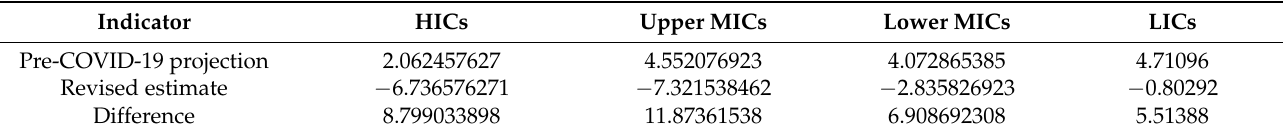
Table 4. Projected and estimated GDP growth in 2020 (IMF 2021b).